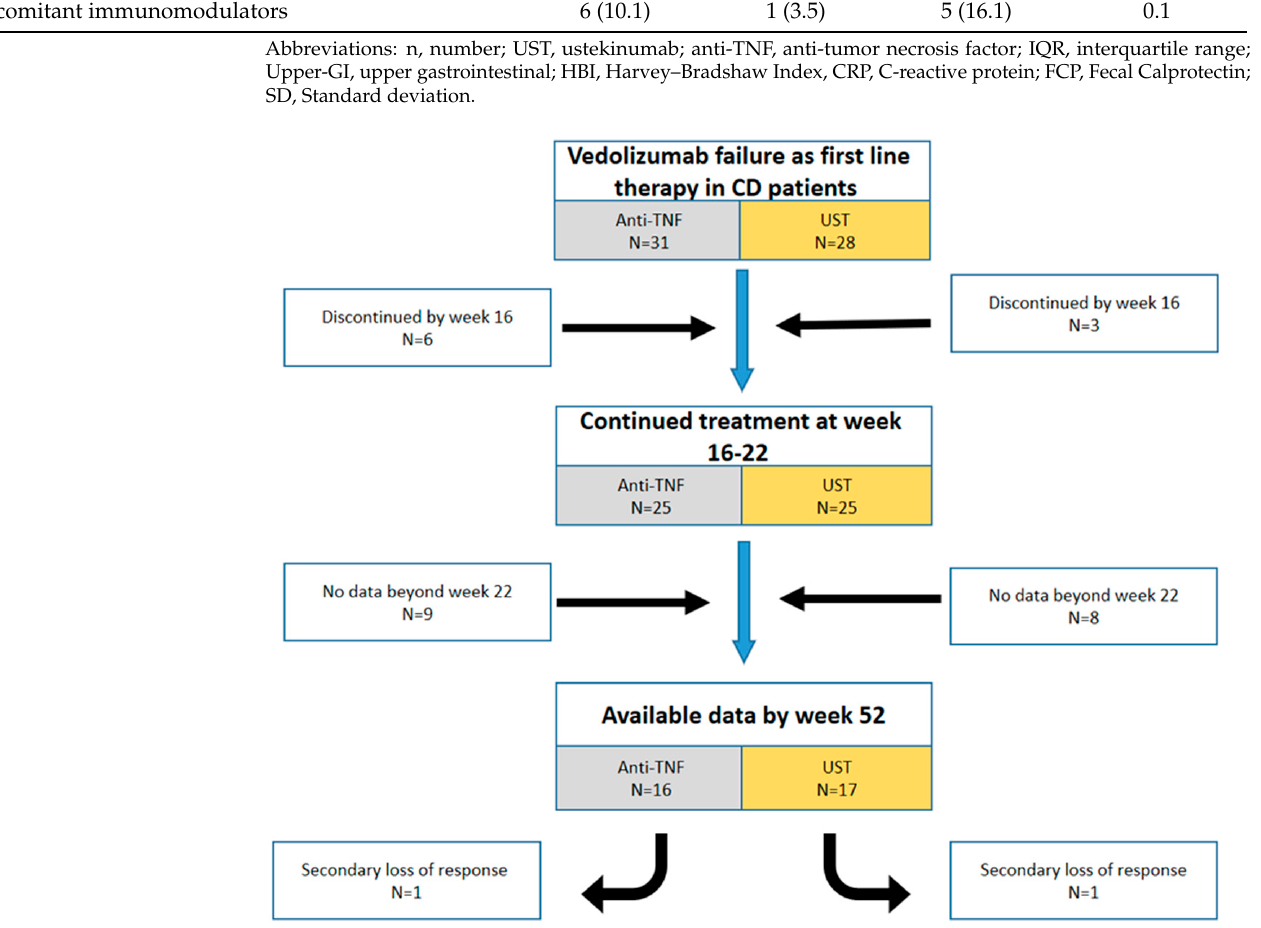
Figure 1. Chart of the patients’ flow during the study period. Abbreviations: CD, Crohn’s disease; anti-TNF, anti-Tumor Necrosis Factor; UST, ustekinumab.